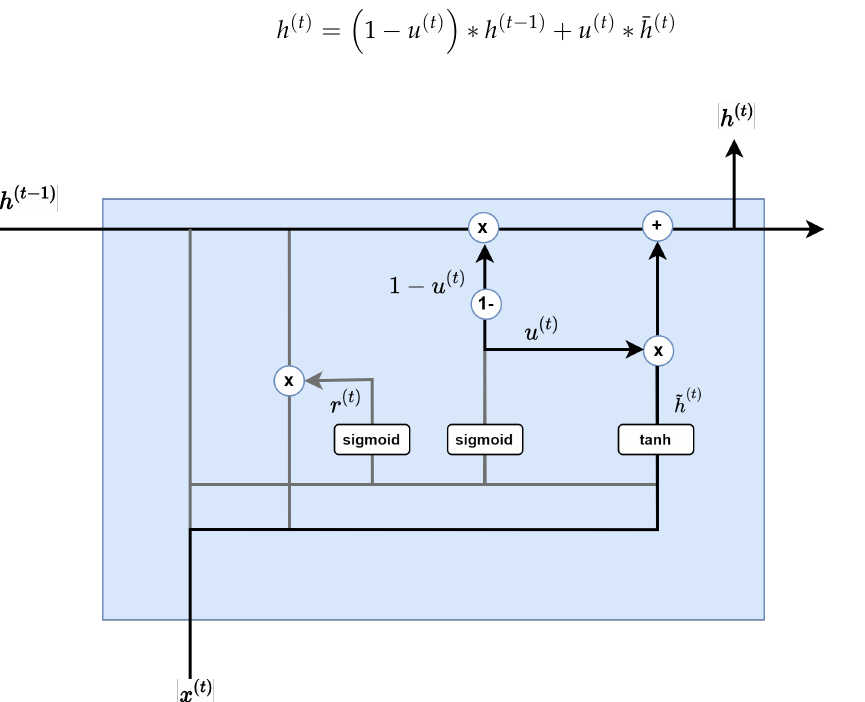
Figure 9. Hidden layer calculation step.